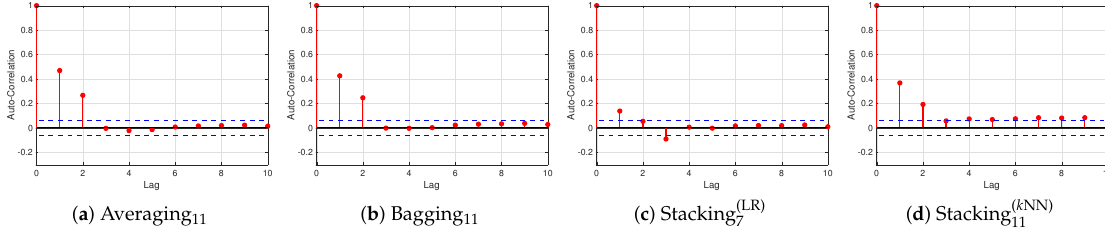
Figure 5. Autocorrelation of residuals for ETH dataset of ensemble models using CNN-LSTM as base learner. -0.200.20.40.60.81